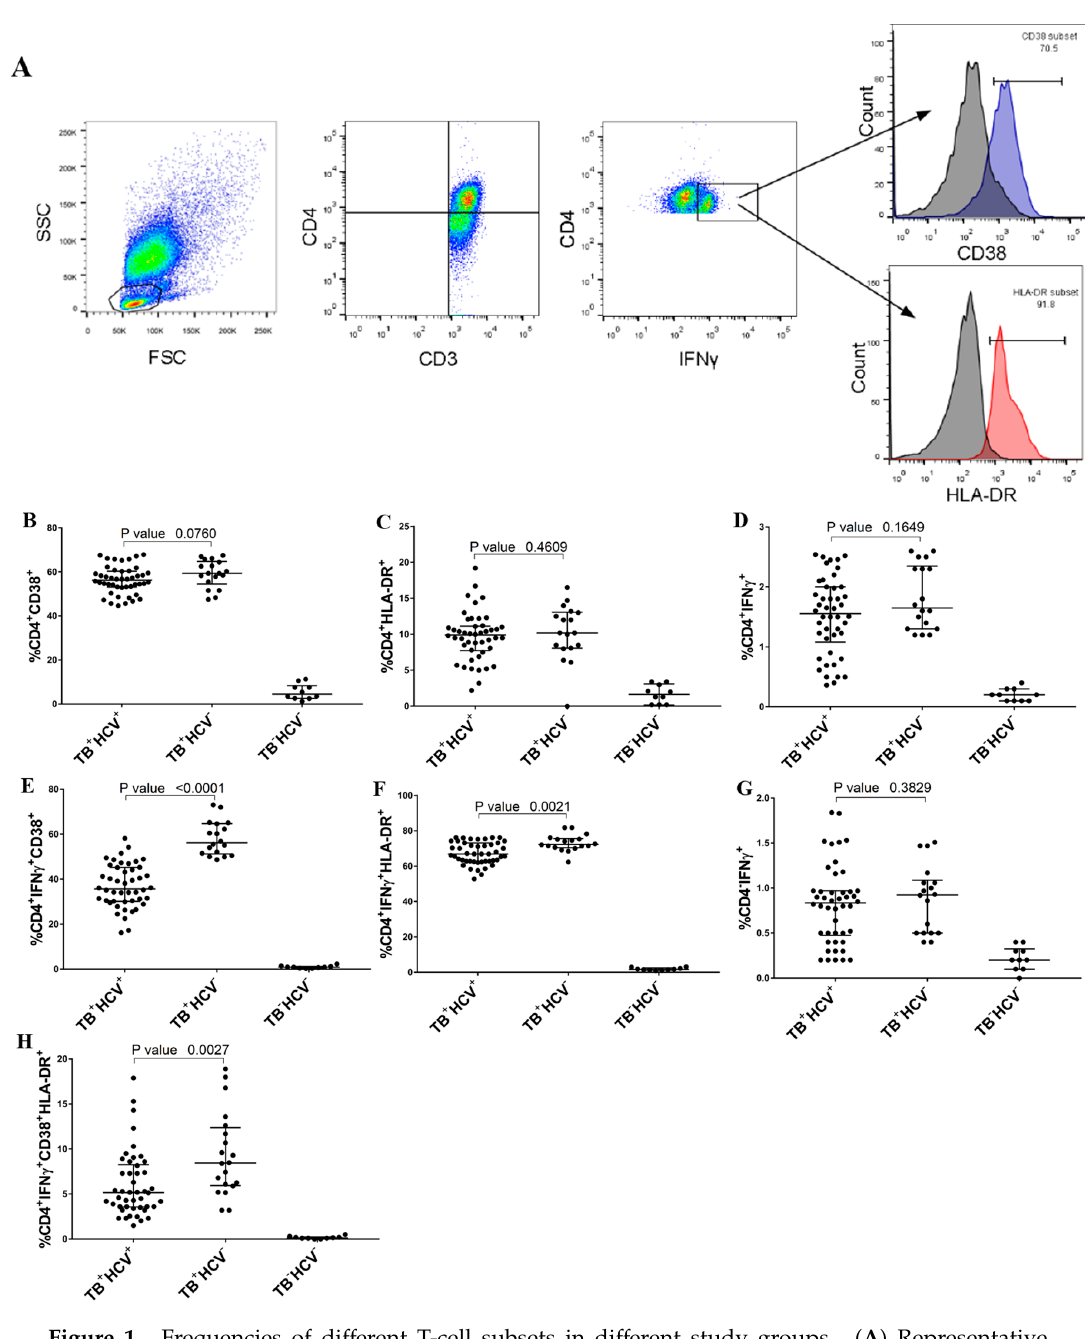
Figure 1. Frequencies of di ff erent T-cell subsets in di ff erent study groups. ( A ) Representative gating strategy for identifying T-cell subsets. Gray-filled histograms represent isotype controls. ( B – H ) Di ff erences in frequency of di ff erent T cells expressing activation markers CD38, HLA-DR, or IFN- γ . Column bars represent median ± interquartile range; p -values were calculated using Mann–Whitney